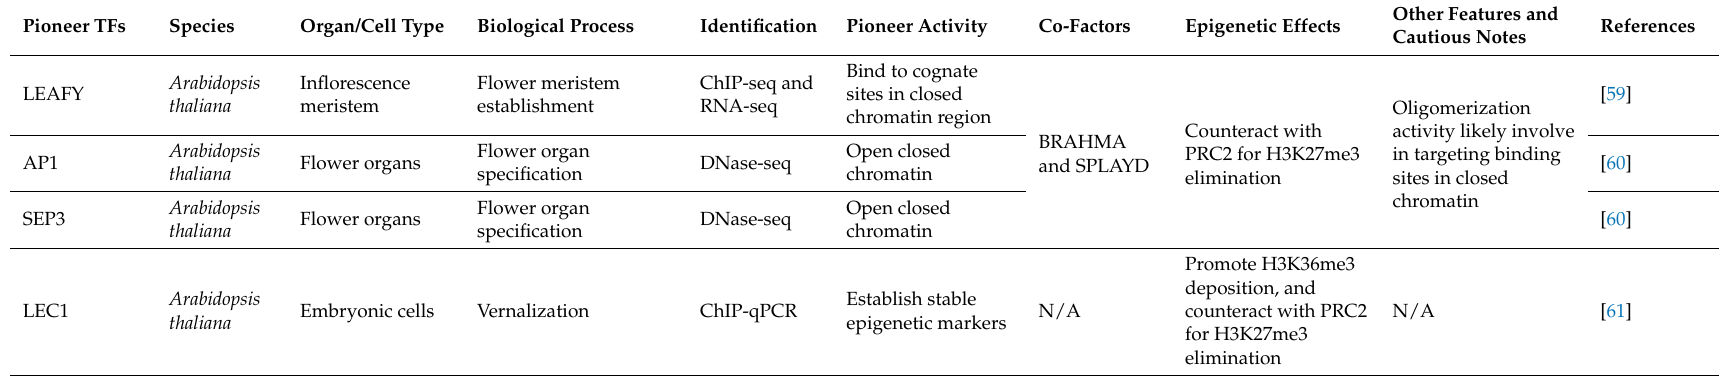
Table 2. Pioneer factors in plants